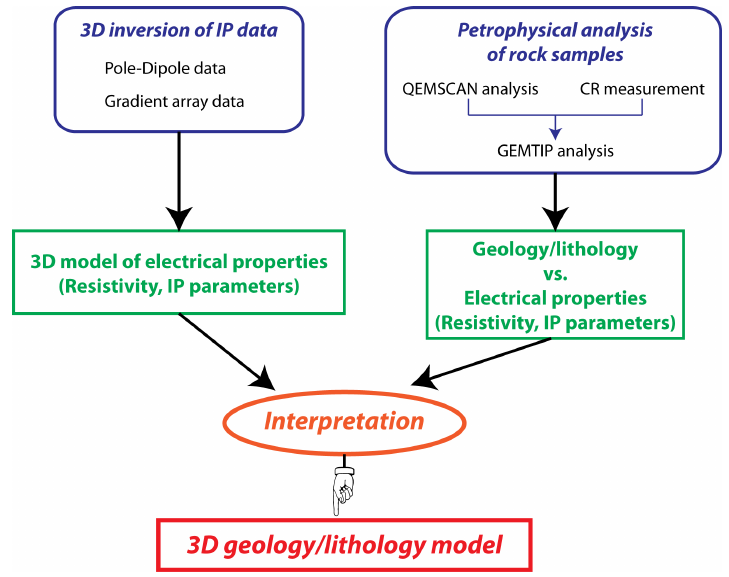
Figure 5. A workflow of the comprehensive interpretation of IP survey data.